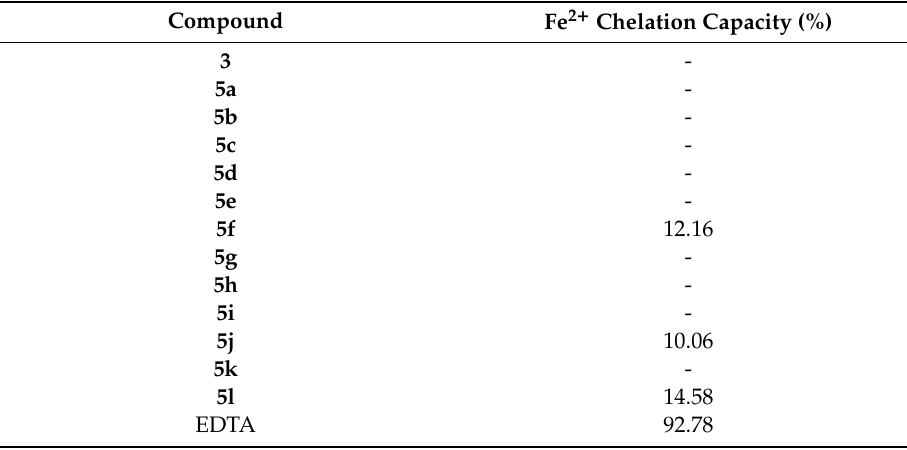
Table 3. Results of the ferrous ions chelation capacity